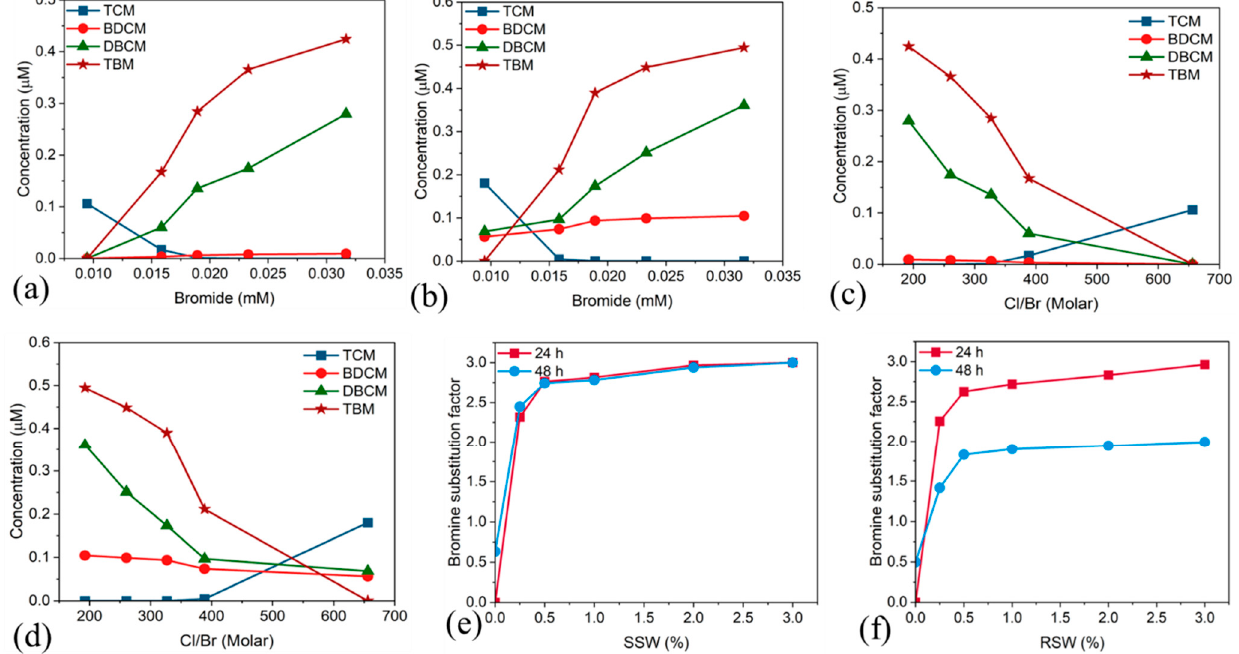
Figure 4. Effect of initial bromide concentration on THM speciation after ( a ) 24 h and ( b ) 48 h; initial chloride-to-bromide (Cl/Br) ratio on speciation of THMs after ( c ) 24 h and ( d ) 48 h; bromine substitution factor for varying seawater intrusion for (e) synthetic seawater (SSW) and ( f ) real seawater (RSW).